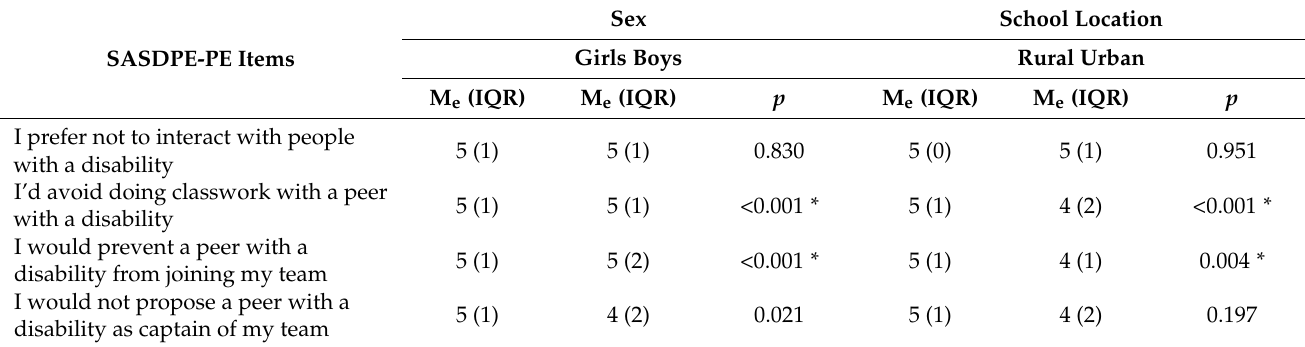
Table 3. Scores for the Scale of Attitudes toward Students with Disabilities in Physical Education– Primary Education (SASDPE-PE) items according to sex and school location.